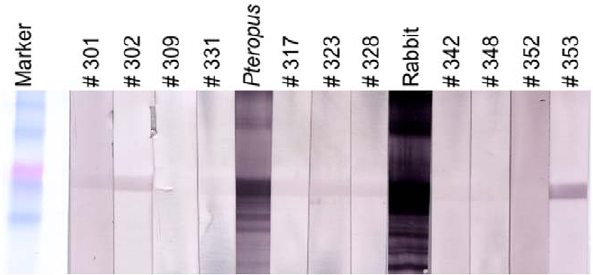
Figure 7. Results of western blot analysis. Samples with Luminex binding MFIs over 750 were tested using a recombinant, purified Nipah virus nucleocapsid protein. The marker is BenchMark Pre-stained Protein Ladder (Invitrogen); the positive control sera are NiV- neutralising Pteropus alecto and polyclonal Rabbit sera raised to recombinant NiV